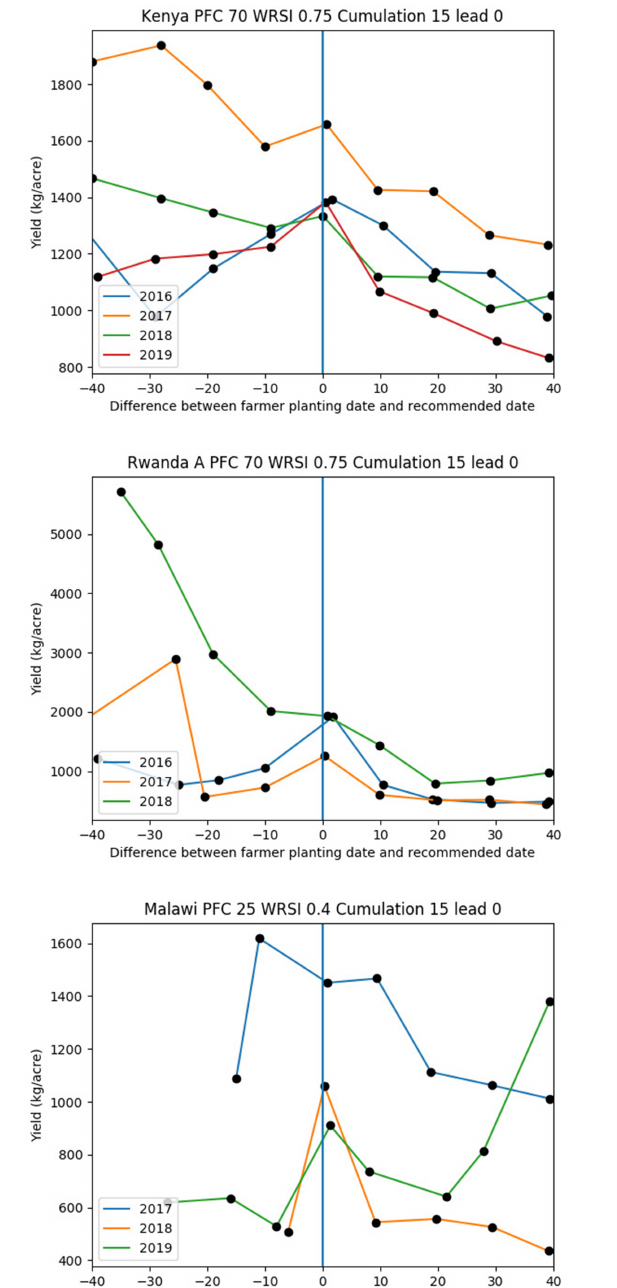
example, a subset of farmers planted significantly before the recommended date and achieved a high yield. It is clear from the rainfall time series, however, that in other years farmers who planted at that time would have experienced a